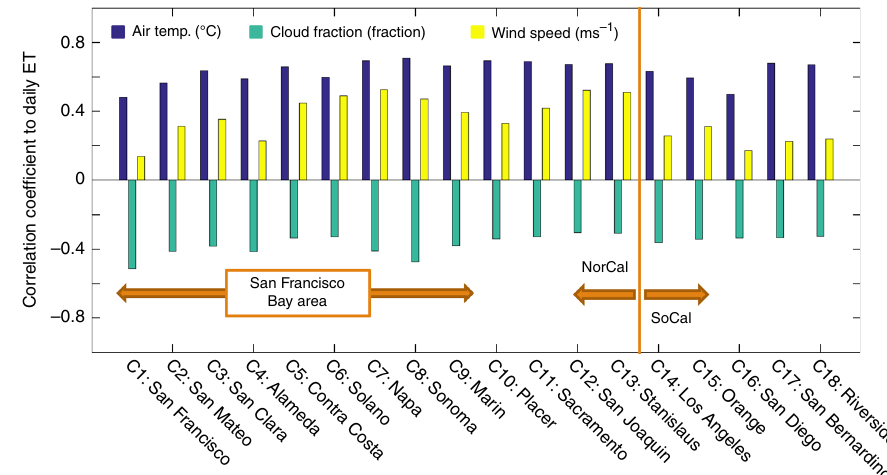
Fig. 3 Variance of the daily evapotranspiration explained by different drivers. Correlation coef fi cients between simulated evapotranspiration (ET) versus air temperature, cloud fraction, and wind speed for conrol simulations. Values are calculated over urban surfaces of each county for June – October of